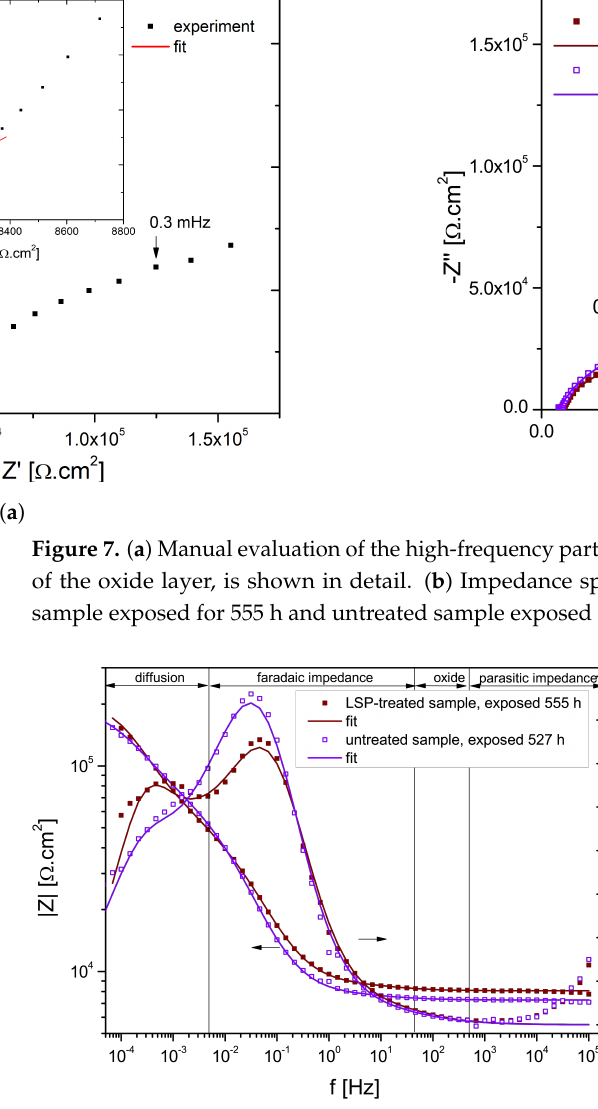
Figure 8. Impedance spectra in Bode diagram of LSP-treated sample exposed for 555 h and untreated sample exposed for 527